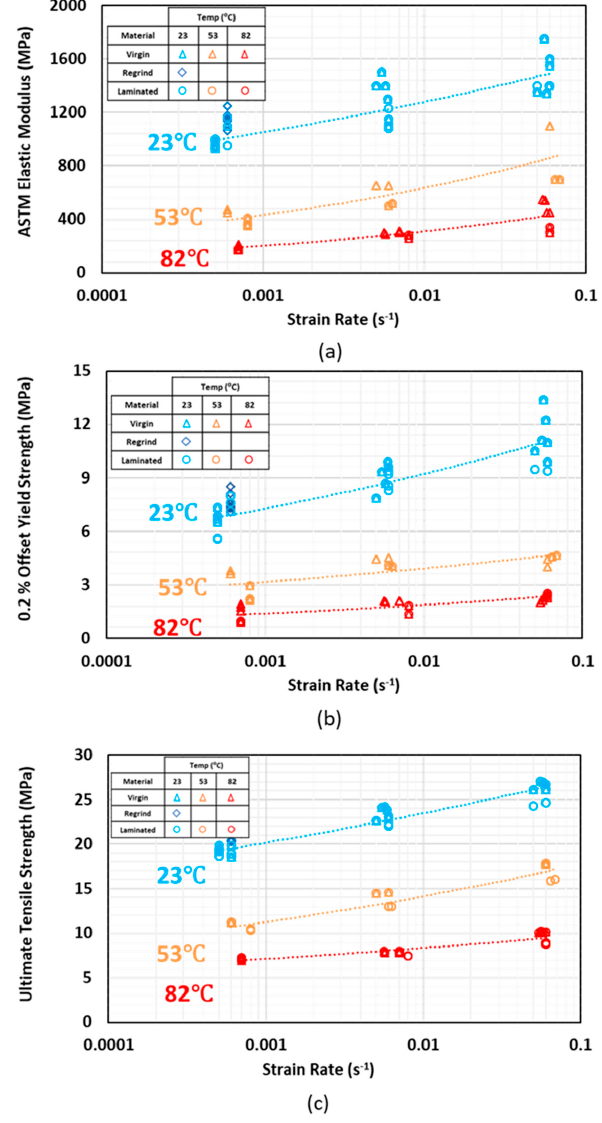
Figure 5. ( a ) Elastic modulus, ( b ) yield strength, and ( c ) ultimate tensile strength variations with strain rate at different temperatures. rate at di ff erent